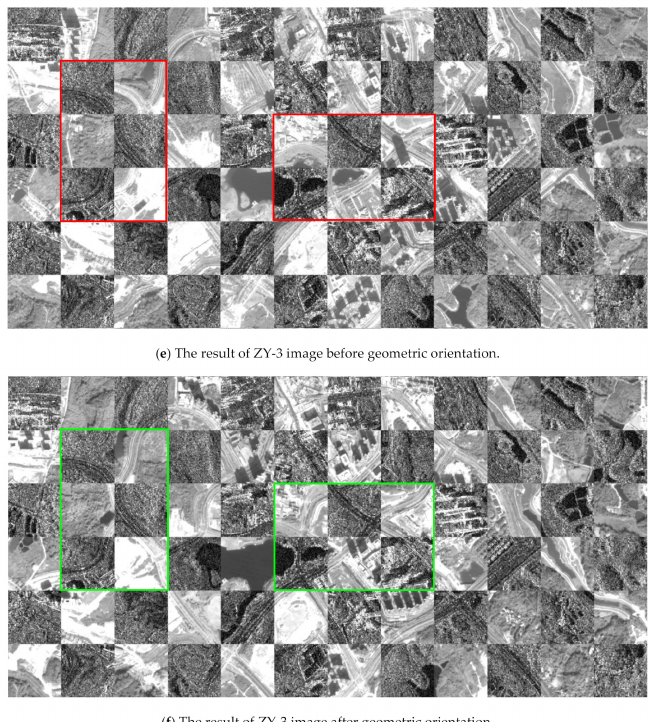
Figure 17. Registration checkerboard overlays of optical images and SAR images with image tiles of 300 × 300 m before and after the orientation process. ( a , c , e ) show the optical satellite images before, and ( b , d , f ) show them after, the geometric orientation with the orientation